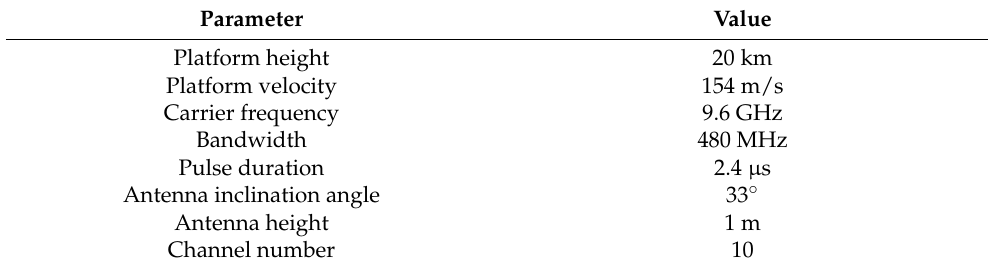
Table 1. Main parameter of the airborne SAR system and simulate 10-channel DBF-SAR. Parameter Value Platform height 20 km Platform velocity 154 m/s Carrier frequency 9.6 GHz Bandwidth 480 MHz Pulse duration 2.4 µ s Antenna inclination angle 33 ◦ Antenna height 1 m Channel number 10